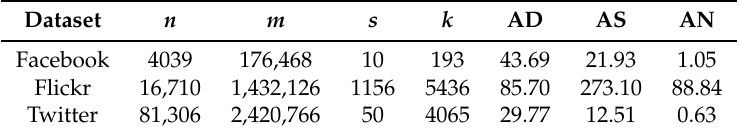
Table 1. Dataset Statistics. n , the number of nodes; m , the number of edges; s , the number of node attributes; k , the number of communities; AD, the average degree; AS, the average size of communities; AN, the average community memberships. We treated all these datasets as directed networks.